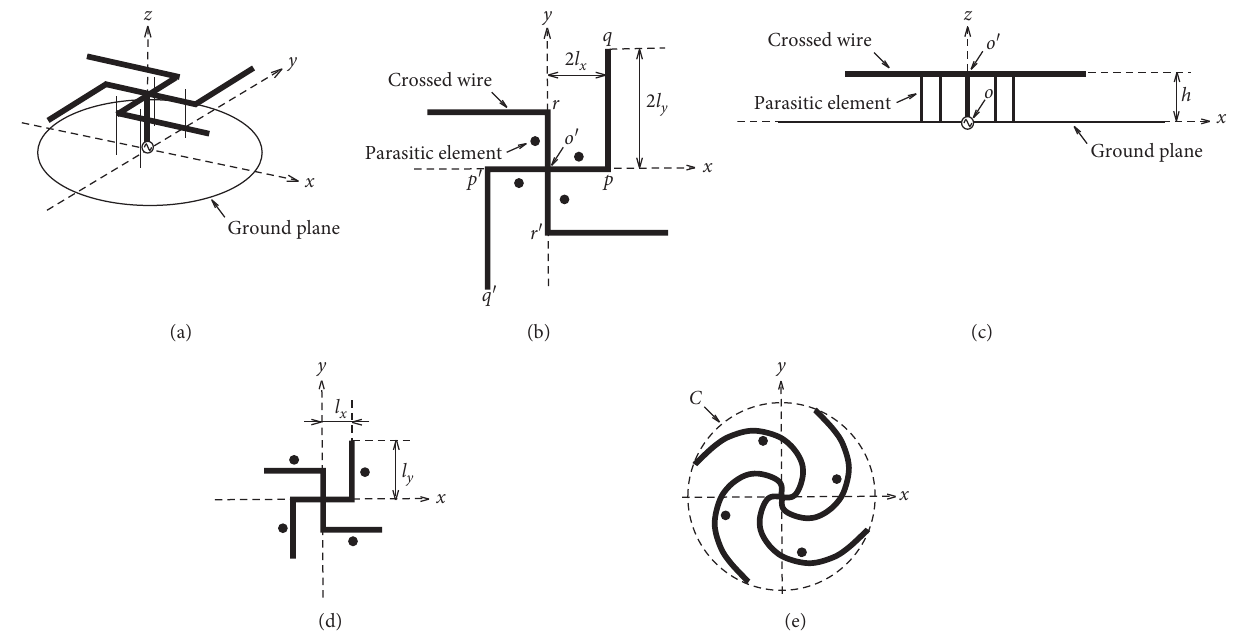
Figure 1: Antenna configurations. (a) Perspective view. (b) Top view of bent-type antenna. (c) Side view. (d) Original antenna [7]. (e) Spiral- type